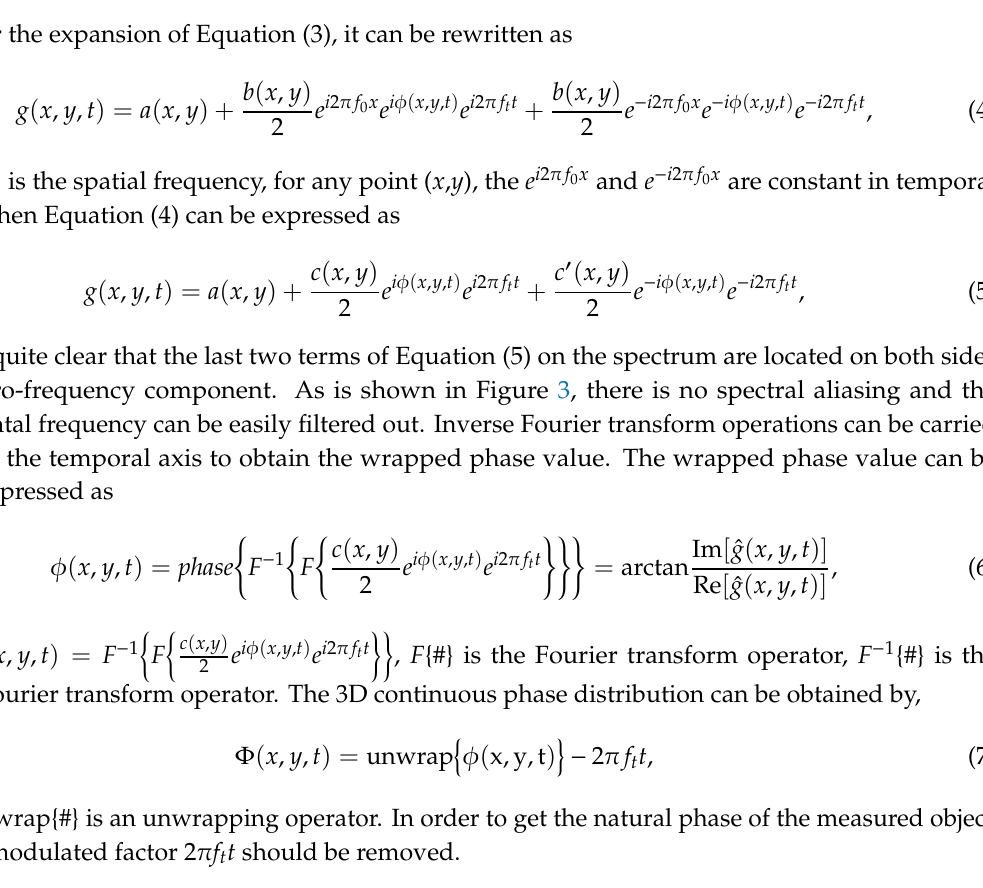
Figure 2. Temporal intensity distribution of the same pixel in n frames phase-shifting deformed images.